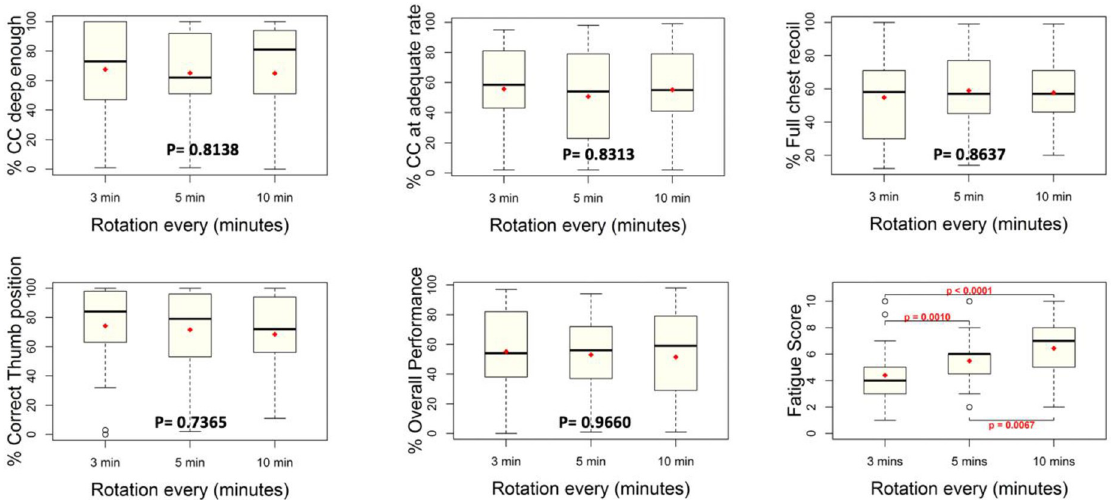
Fig 3. Box-plots comparing different compression performance metrics and provider self-reported fatigue scores, as they rotated every 3, 5 and 10 minutes. Statistically significant difference was noted in the level of fatigue when providers performed CCs for longer durations Note: p-values reported within each box-plot.